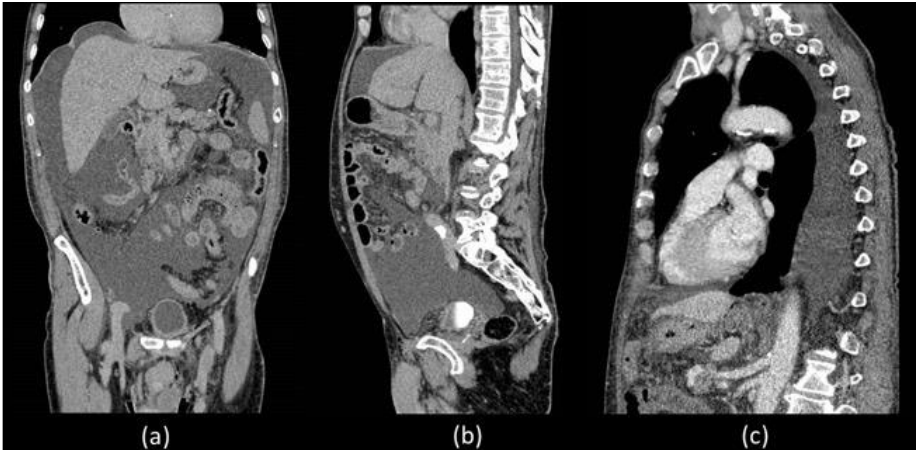
Figure 1. Coronal ( a ) and sagittal ( b ) abdominal CECT showed massive ascites in supra and in- framesocolic recesses. Non-hepatic diseases were recorded. ( c ) Sagittal thorax CECT demonstrated left pleural effusion.